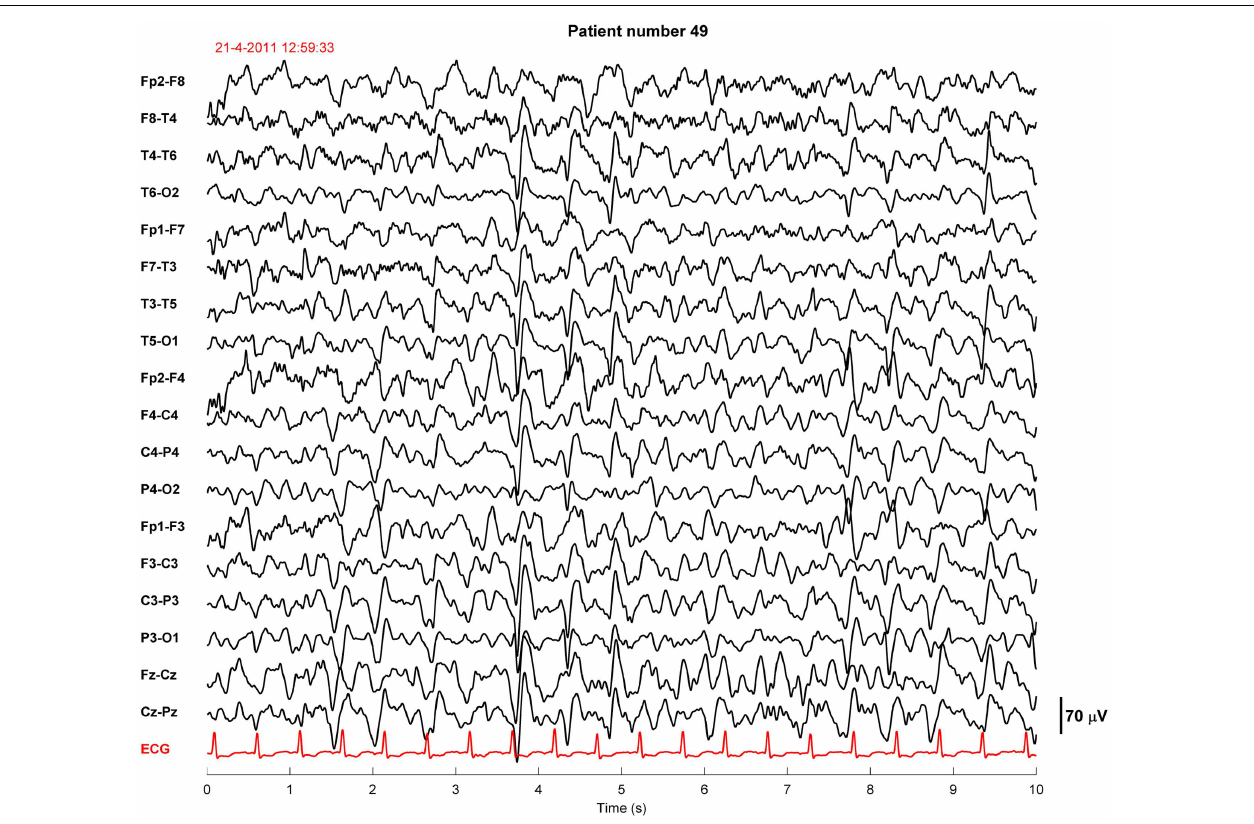
The EEG epoch was recorded approximately 40h after cardiac arrest, after restoration of normothermia. Filter settings, 0.5–30Hz.This patient had a good